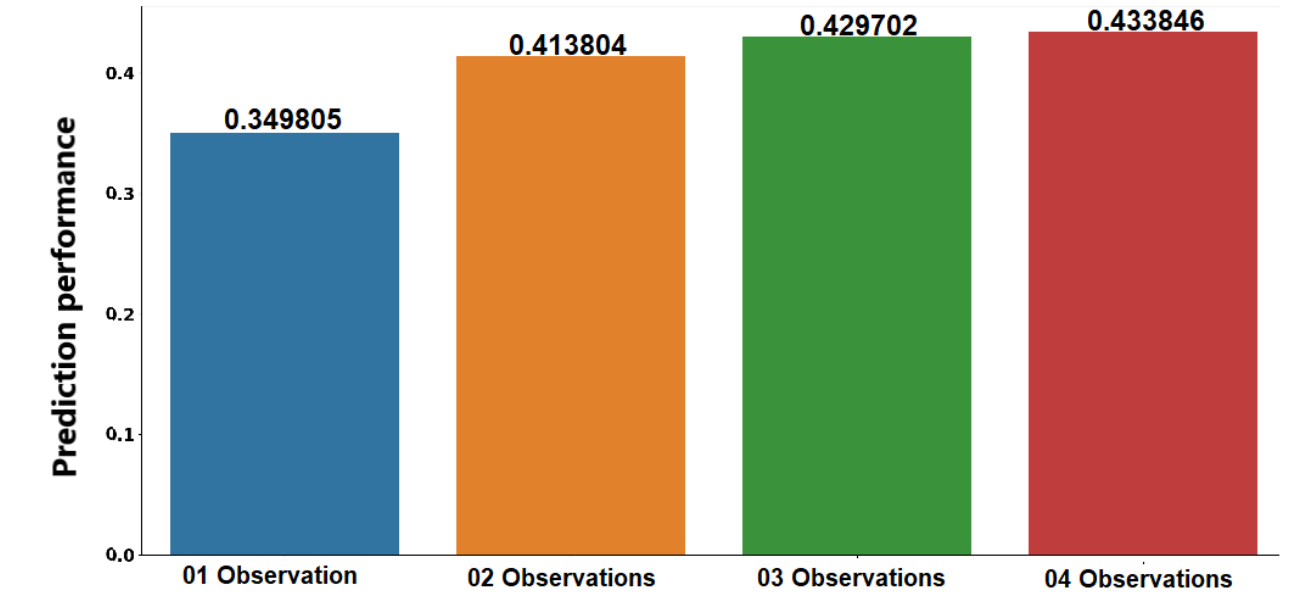
Figure 10. Prediction performance of sociability patterns.